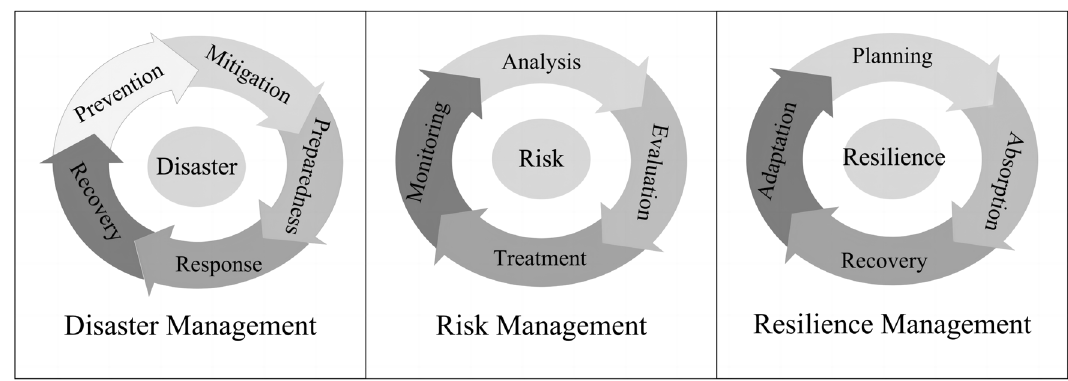
Fig. 4 A comparison between disaster management, risk management, and resilience